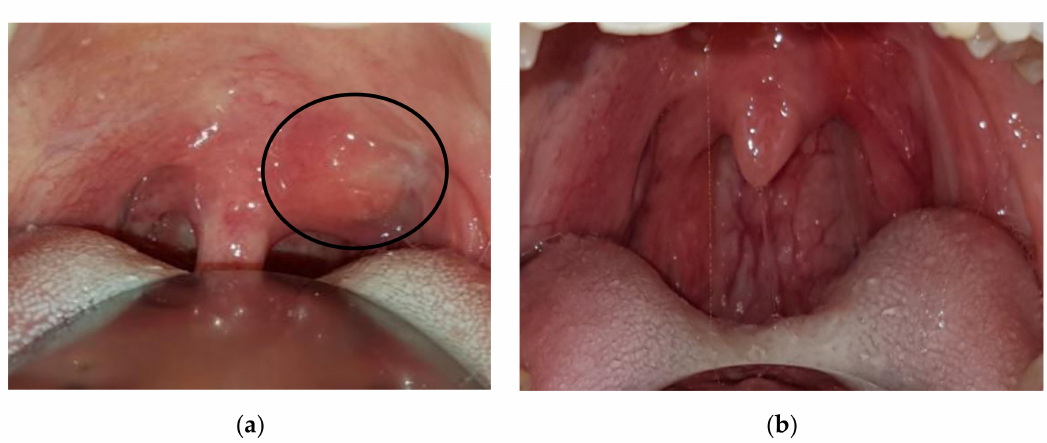
Figure 3. Patient 4: ( a ) Periuvular lesion of the soft palate (circle), ( b ) resolution after corticosteroid